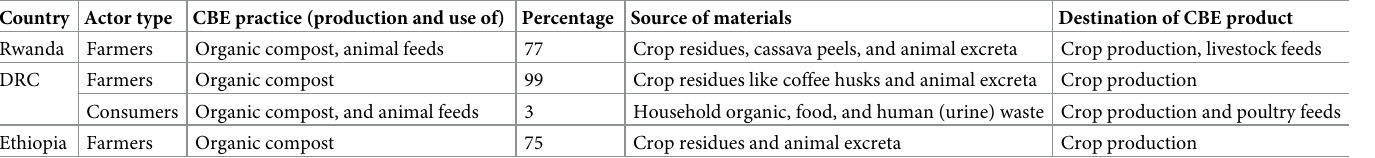
Table 3. Current circular bioeconomy (CBE) practices.